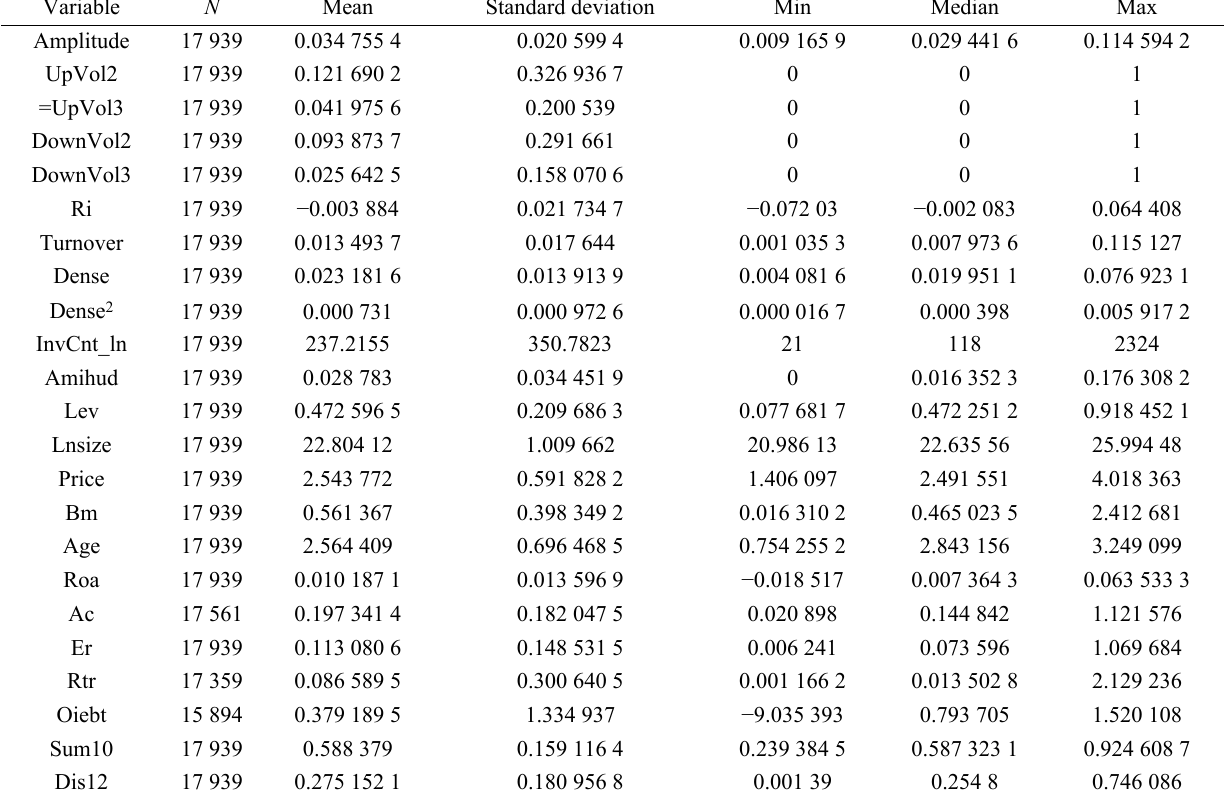
Table 12 Descriptive statistics of investors’ social network and asset pricing.